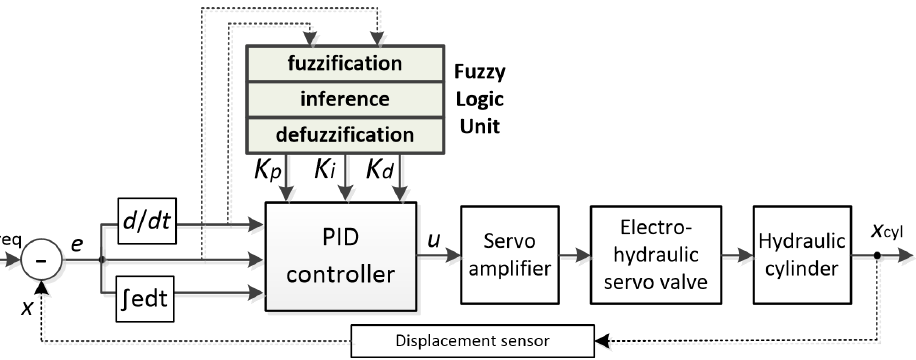
Figure 15. Fuzzy PID controller diagram of a hydraulic transplanting manipulator by [77]; x req , x cyl —required and actual position of hydraulic cylinder, K p , K i , K d —PID controller